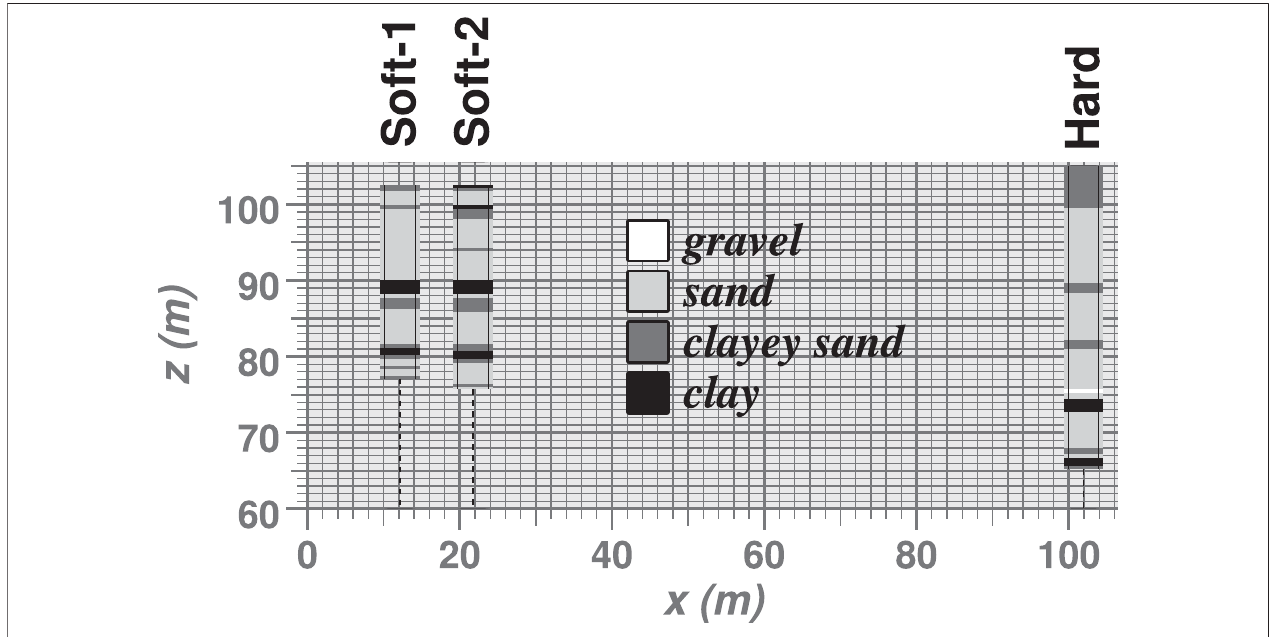
FIGURE 1 | Lithologic data within a geologic cross-section, Savannah River Site, South Carolina. Data labeled “ Soft-1 ” and “ Soft-2 ″ are inferred from resistivity logs, and data marked “ Hard ” are obtained from core descriptions.